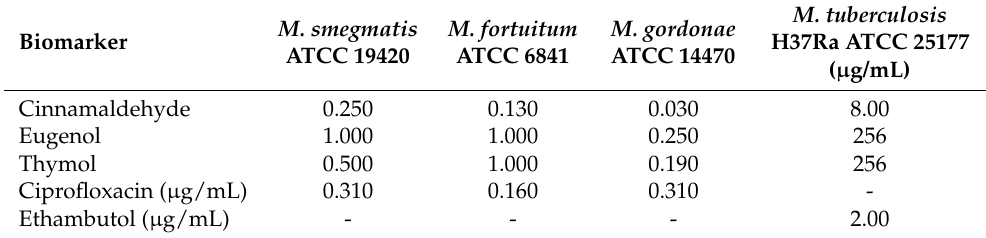
Table 2. Mean MIC values (mg/mL) of predicted active compounds towards selected Mycobac- terium strains.